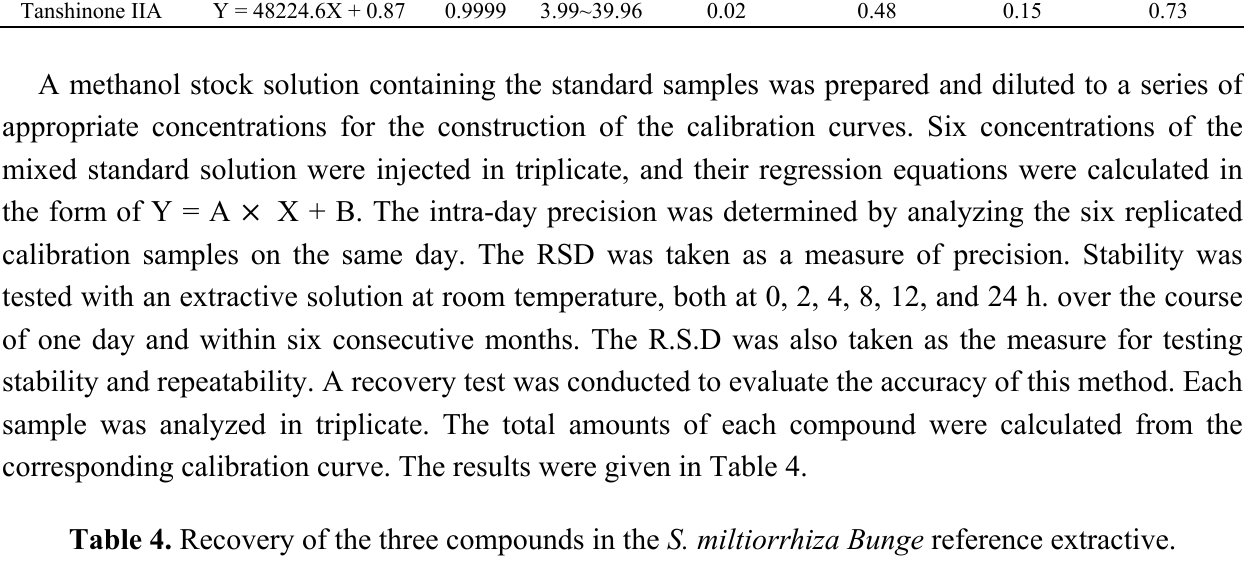
Table 4. Recovery of the three compounds in the S. miltiorrhiza Bunge reference extractive. Analyte